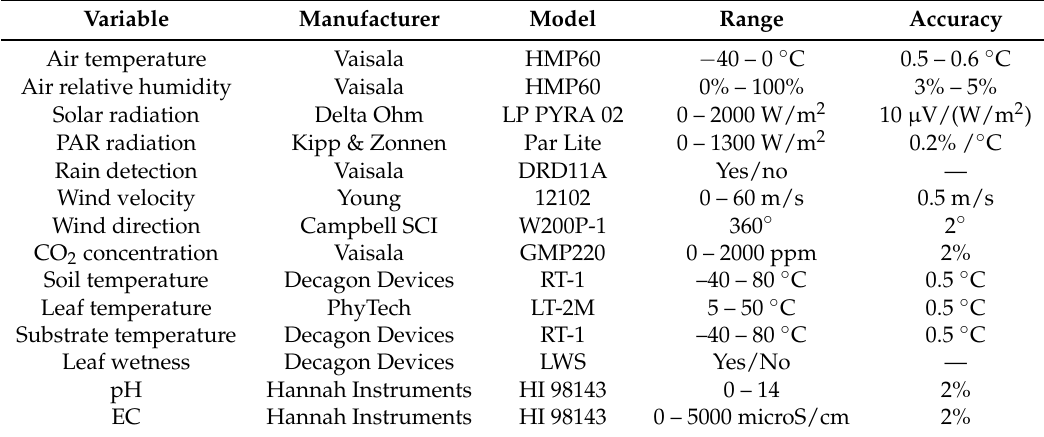
Table 1. Different variables sampled with the main characteristics of the sensors installed.